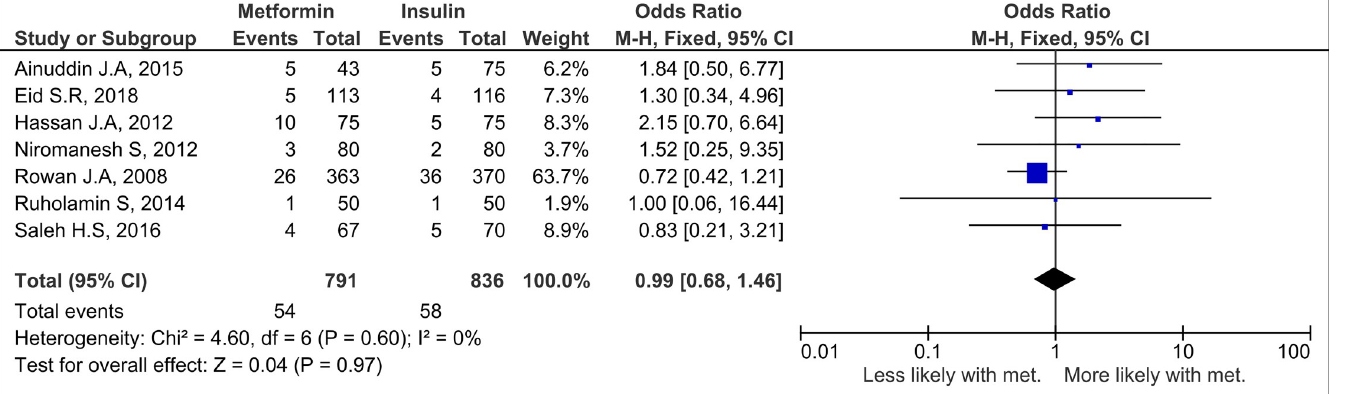
PLOS Medicine| https://doi.org/10.1371/journal.pmed.1002848 August 6,